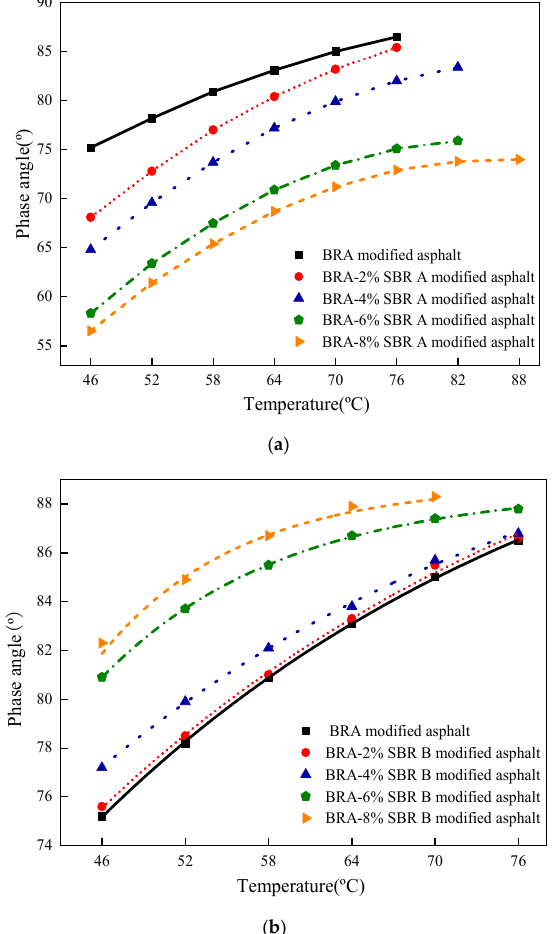
Figure 3. Phase angle of specimens. ( a ) BRA and BRA-SBR A modified asphalt; ( b ) BRA and BRA-SBR B modified asphalt.